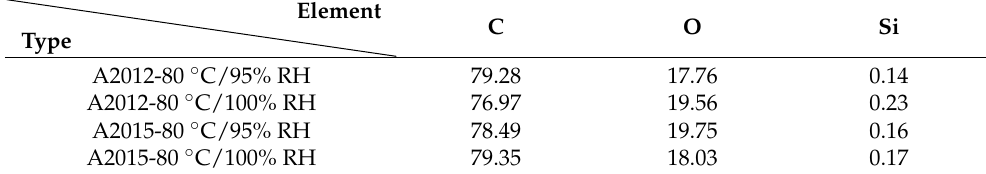
Table 4. Different element content in